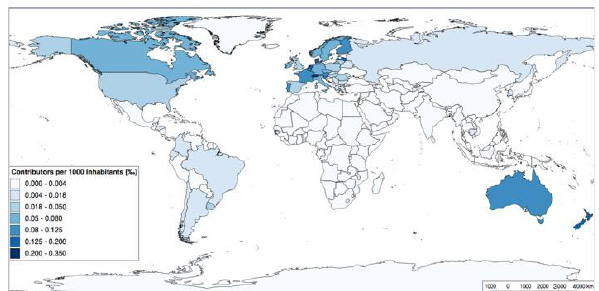
Figure 4. Map of geocoded unique contributors share out of every 1000 country inhabitants [‰] (world country map by GADM: